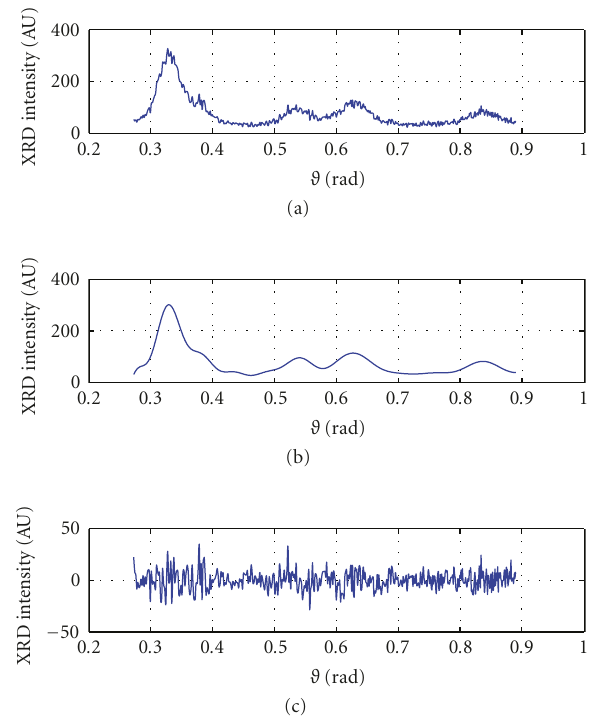
Figure 3: Three nm Au synthetic sample: (a) noisy (NSR = 10%) synthetic XRD intensity profile as a function of the scattering angle ϑ ; (b) filtered XRD intensity profile; (c) di ff erence between mea- sured and filtered